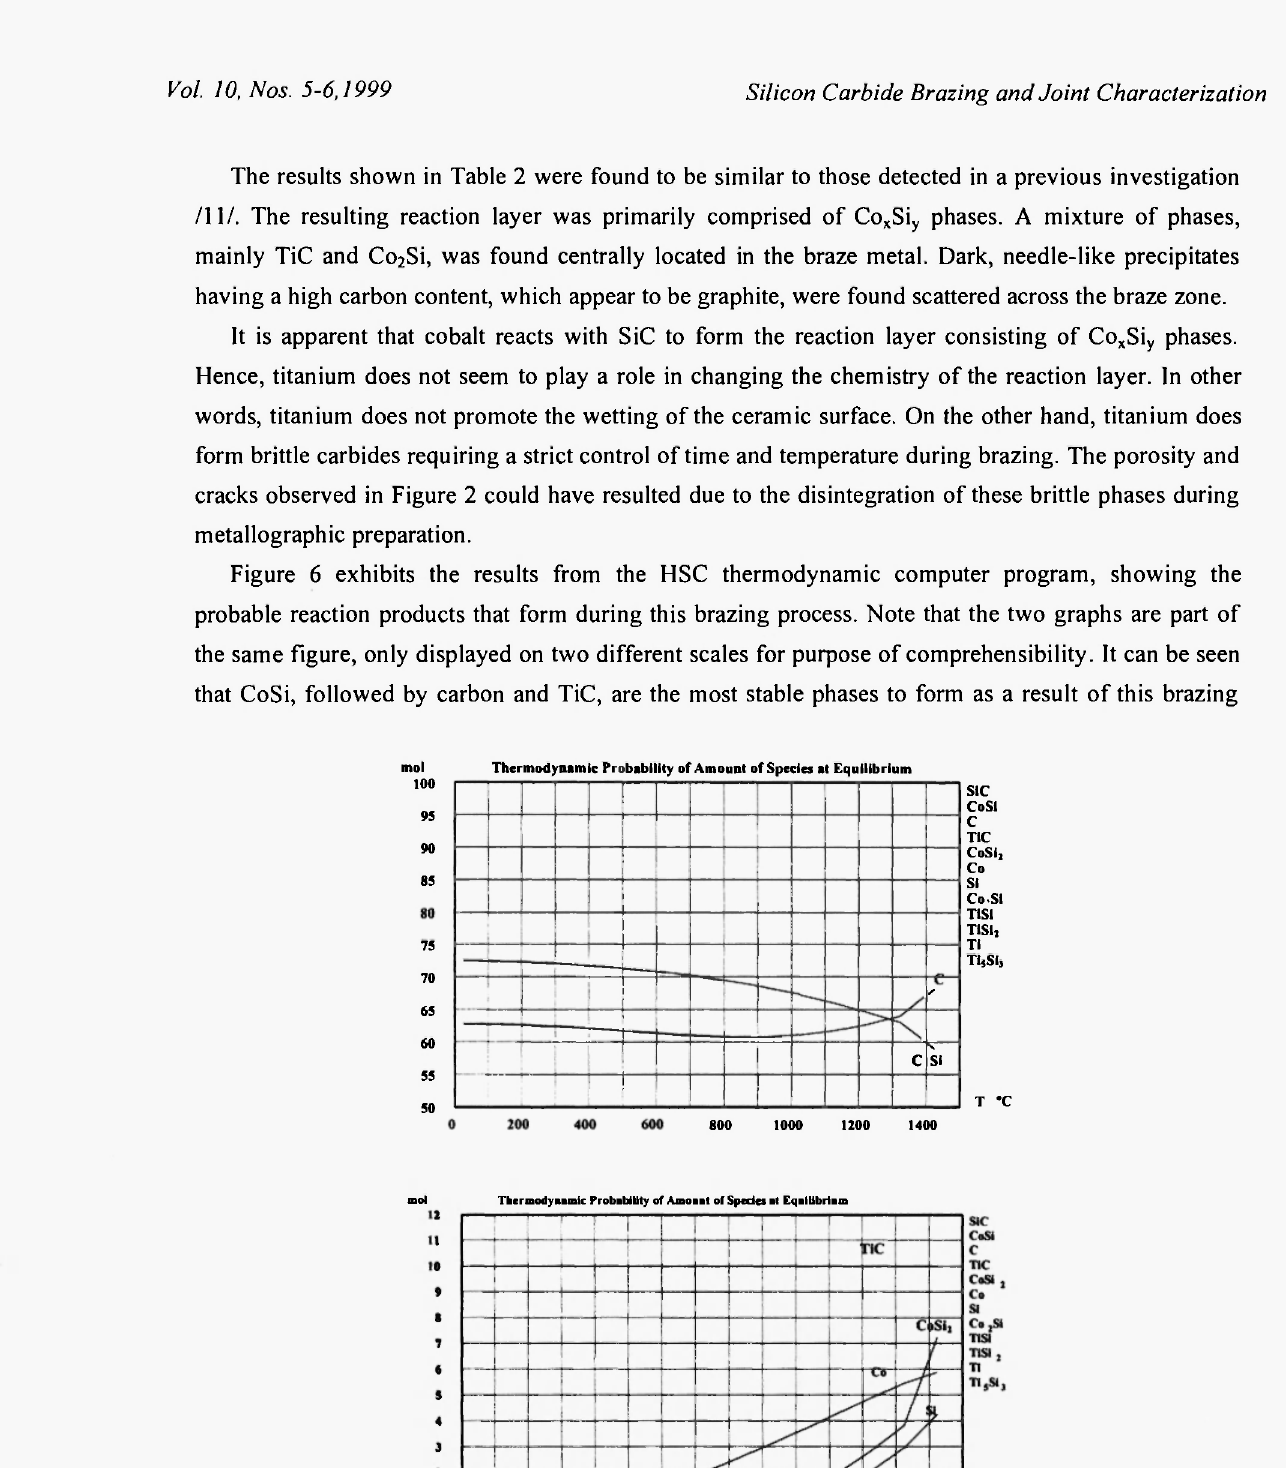
Fig. 6: HSC thermodynamic computer simulation results showing the amount of the probable reaction products formed at